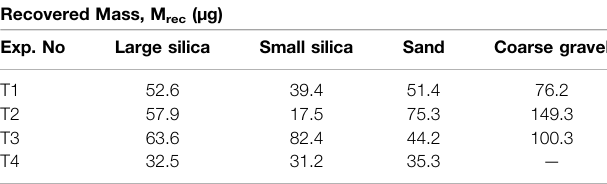
TABLE 7 | Fluorescent tracer column test results: the kinematic porosity (n k ) and dispersivity ( α ) values for the media. Large silica Small silica Sand Coarse Exp. No